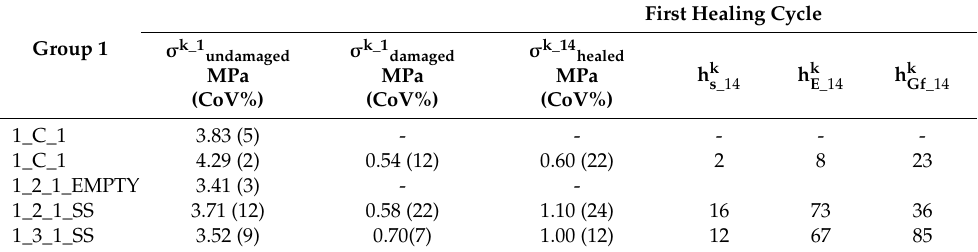
Table 3. Group 1: Flexural test results and indices of healing for one damage-healing cycle.